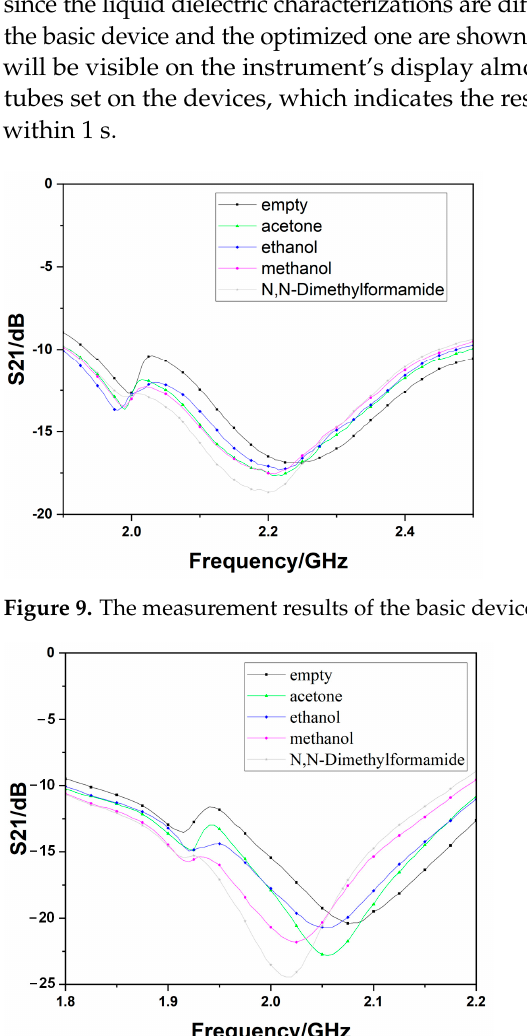
Figure 10. The measurement results of the optimized device.